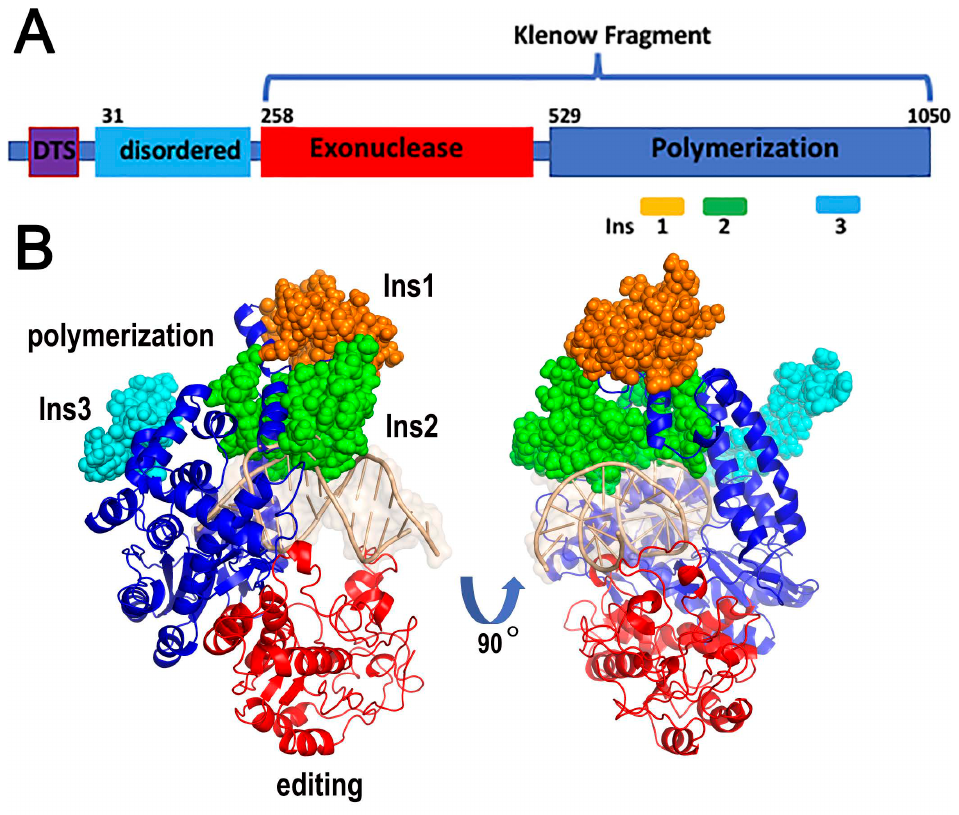
Figure 1. Structural architecture of AtPOLIs. ( A ) AtPOLIs, like all POPs, are modular polymerases with exonuclease (editing) and polymerization domains. AtPOLIs harbor a dual targeting sequence (DTS) for mitochondria and plastid localization and a N terminal disordered region of approximately 200 amino acids. ( B ) Homology model of AtPOLIBs: The three unique amino acid insertions in the polymerization domain of AtPOLIs are represented in a ball stick representation and colored in orange, green, and